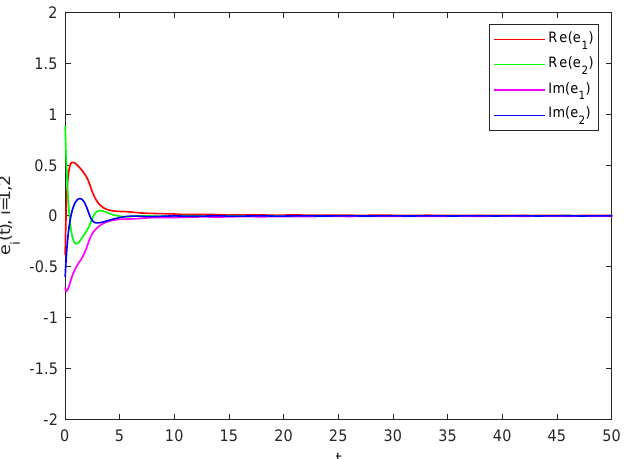
Figure 6. Phase trajectory of imaginary part of the FCINN (27).